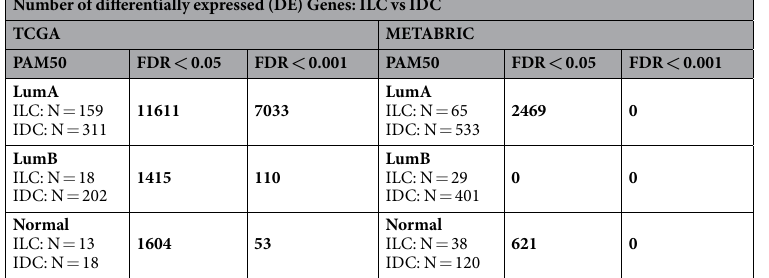
Table 1. Number of differentially expressed genes between ILC and IDC. Number of differentially expressed genes with different cutoffs of p-value (0.05 and 0.001) in TCGA and METABRIC. Tumors within different breast cancer intrinsic molecular subtypes (PAM50) were analyzed